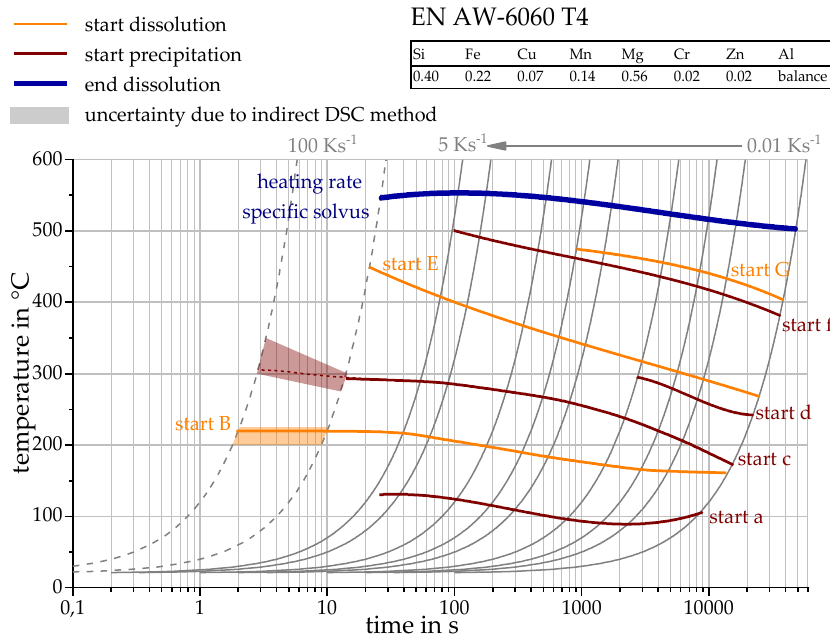
Figure 1. Continuous heating dissolution diagram of EN AW-6060 T4 [20].